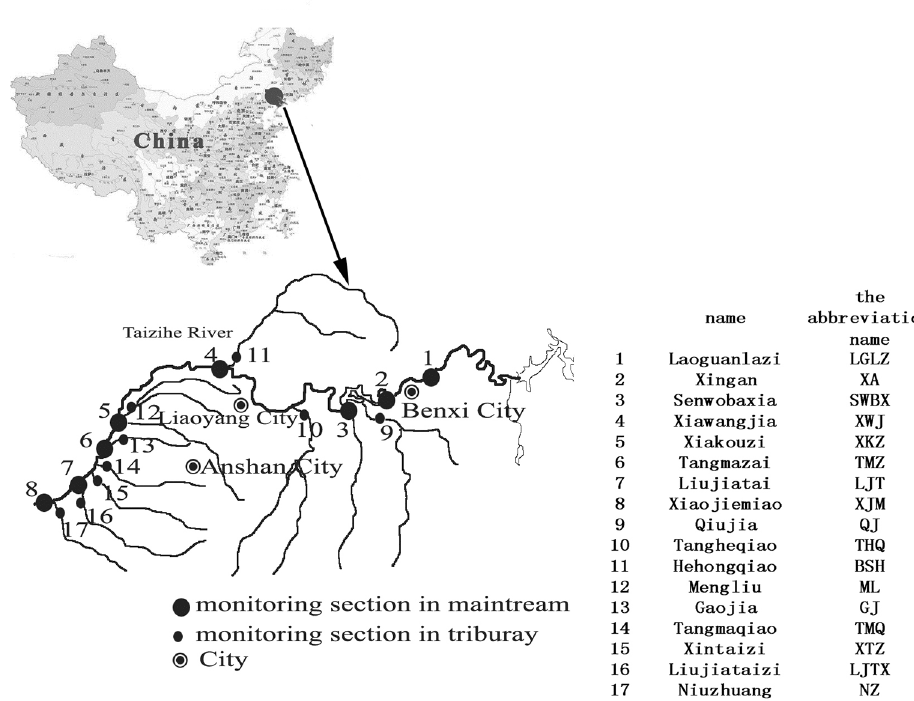
Fig 1. Locations of the monitoring stations in Taizihe